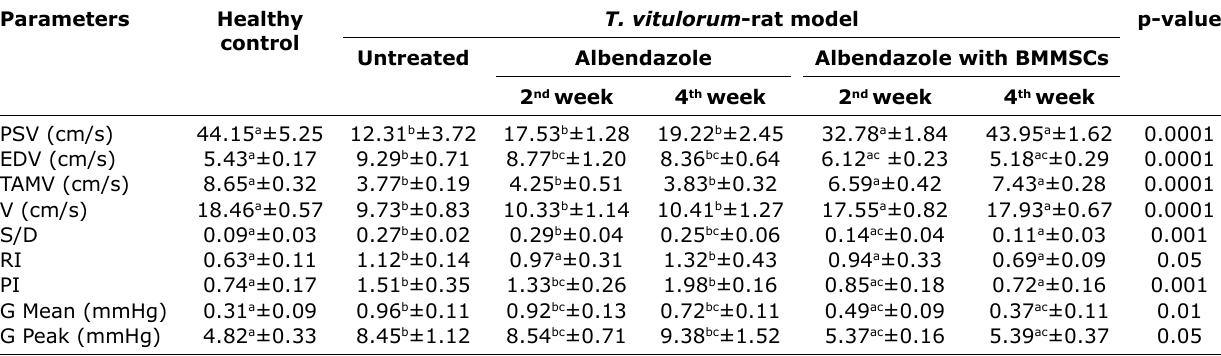
V=Velocity mean, S/D=Systolic/diastolic, RI=Resistance index, PI=Pulsatility index, T. vitulorum=Toxocara vitulorum